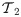
The transformation T2 in the proof of Proposition 25.